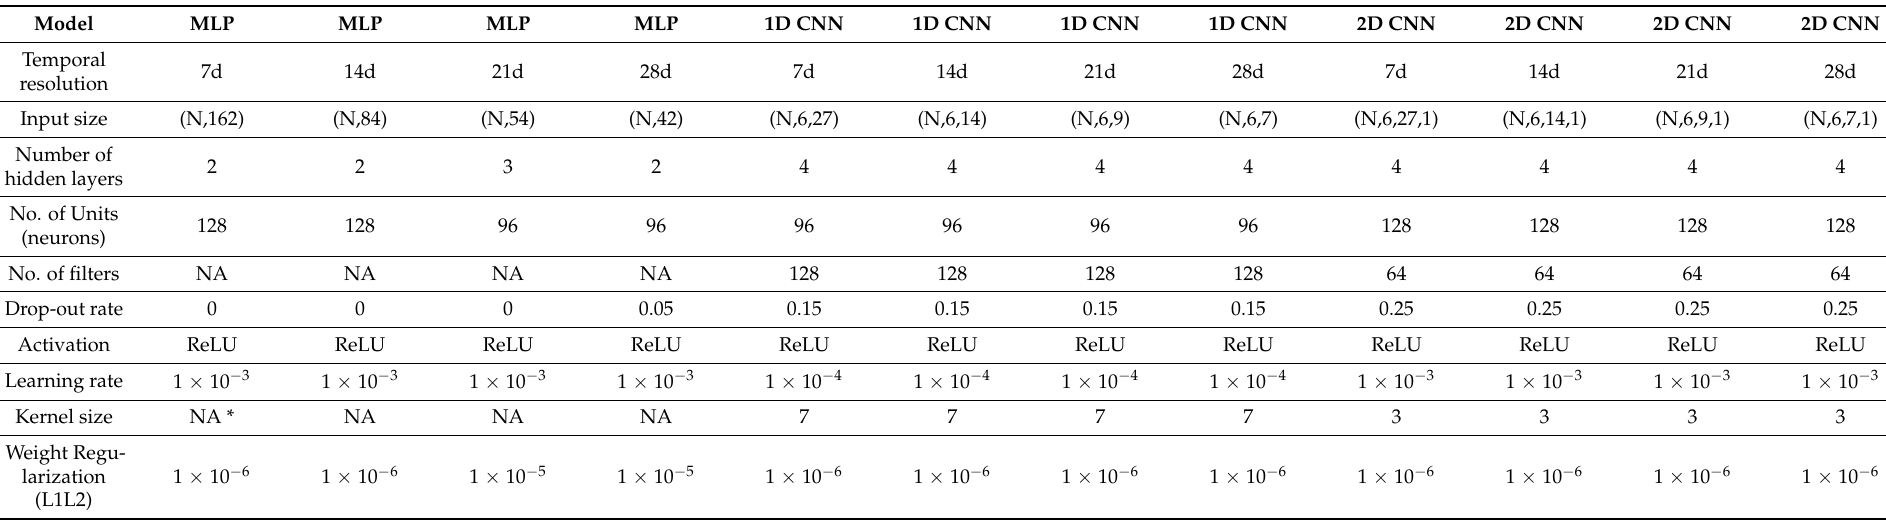
Table 2. The hyperparameter values of the optimized models as obtained by using the randomized search method of Keras